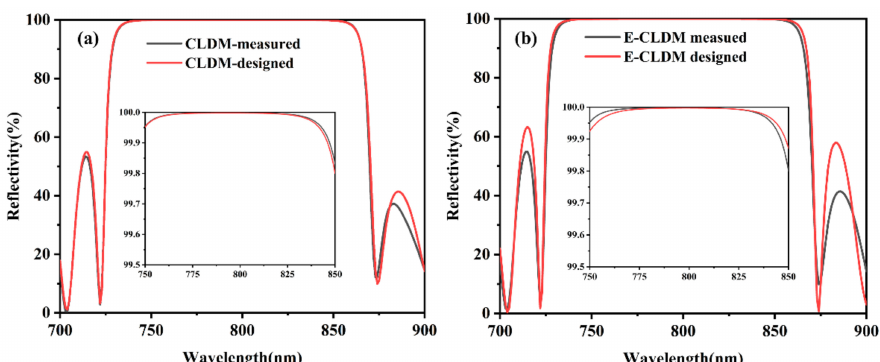
Figure 4. Measured and designed reflectivity of CLDM ( a ) and modified-electric-field CLDM (E-CLDM) ( b ) for p-polarization of 45 ◦